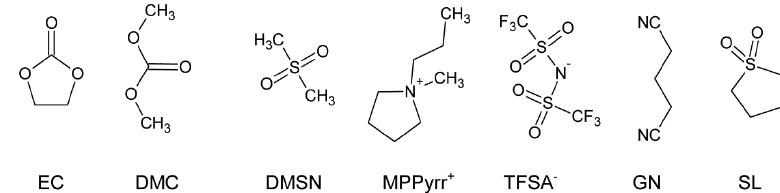
Figure 1. Chemical structures of ethylene carbonate (EC), dimethyl carbonate (DMC),